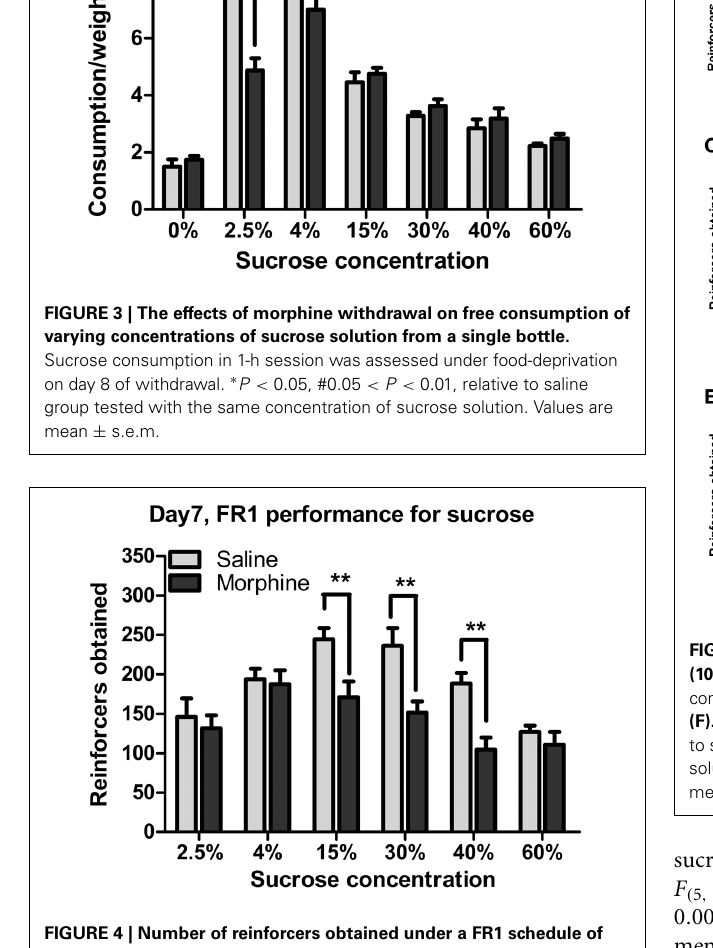
FIGURE 4 | Number of reinforcers obtained under a FR1 schedule of reinforcement on day 7 of withdrawal. ∗∗ P < 0 . 01, relative to saline group tested with the same concentration of sucrose solution. Values are mean ± s.e.m.